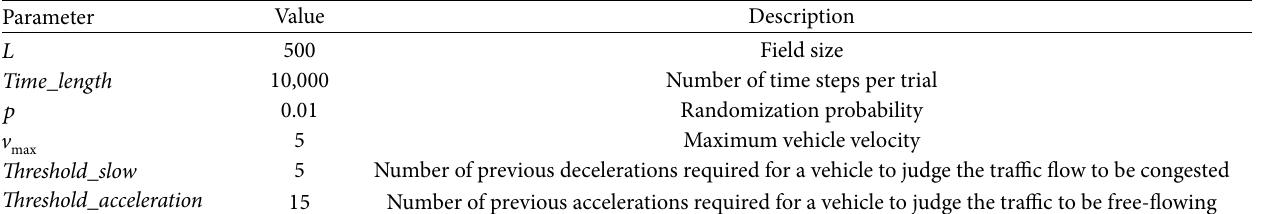
Table 1: Parameters used in the